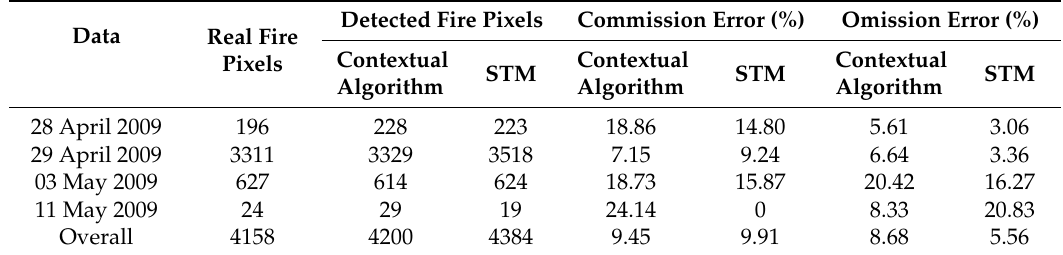
Table 2. Accuracies of the STM method and contextual algorithm